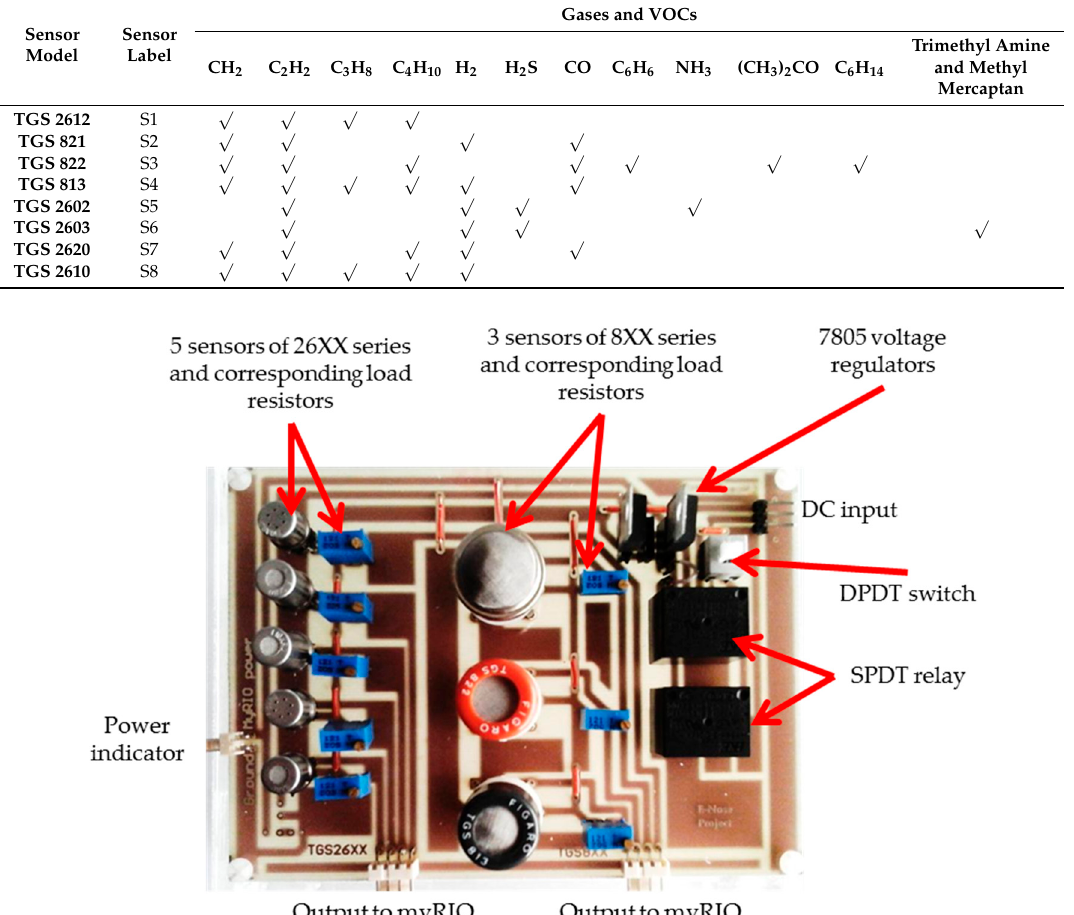
Figure 3. The electronic nose sensor panel. In the figure DC, DPDT, and SPDT stands for direct current, double pole double throw, and single pole double throw, respectively. Table 1. Figaro gas sensors used in the E-Nose design and the gases or volatile organic compounds (VOCs) to which the sensors are sensitive.